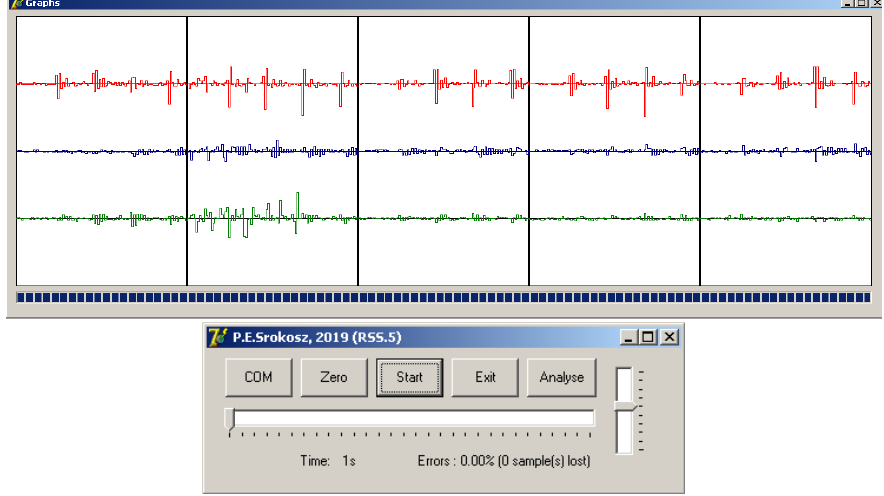
Figure 10. The Research Supervision System application windows.